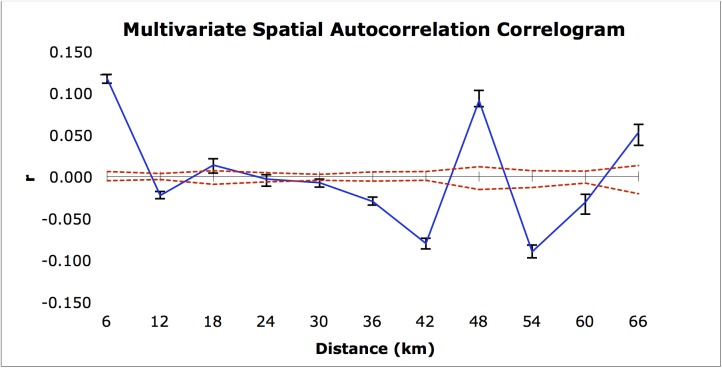
Correlogram from spatial autocorrelation analysis.Solid line indicates the autocorrelation coefficient, r (-1–1), between individuals at each distance class. Dashed lines are 95% confidence intervals based on 1000 random permutations of all individuals. Values above and below dashed lines indicate significant spatial structure. Error bars result from 1000 permutations of individuals within each distance class.